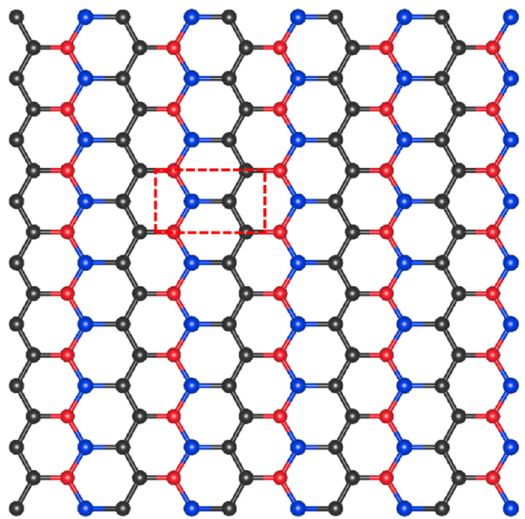
Figure 2. Atomic structure of carbon and boron nitride hybrid (HCBN) with alternating chains optimized at the Perdew, Burke, and Ernzerhof (PBE) level. The black, blue, and red spheres represent carbon, boron, and nitrogen atoms, respectively.